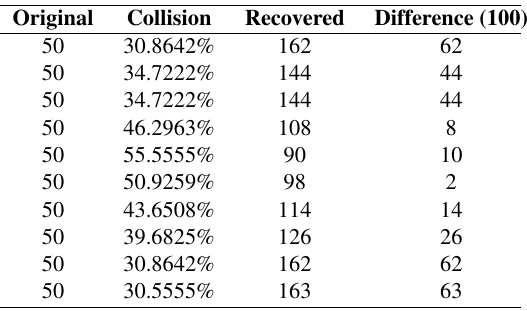
Figure 4: Synthetic point cloud clustered before the intensity re- covery (a). Synthetic point cloud clustered after the intensity re- covery (b). Table 1: Intensity data recovered through the created